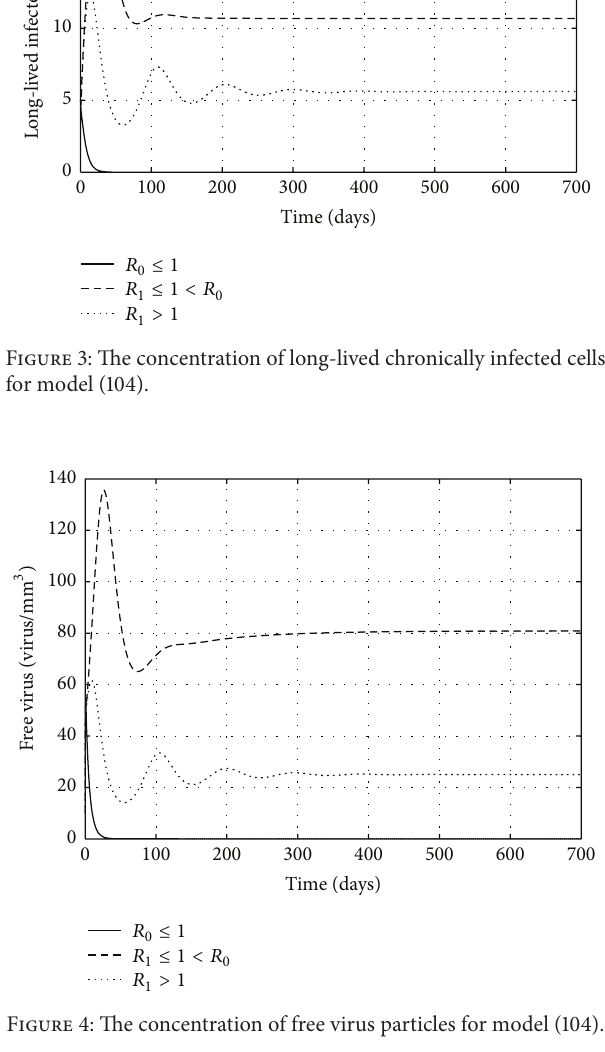
Figure 2: The concentration of short-lived infected cells for model (104).